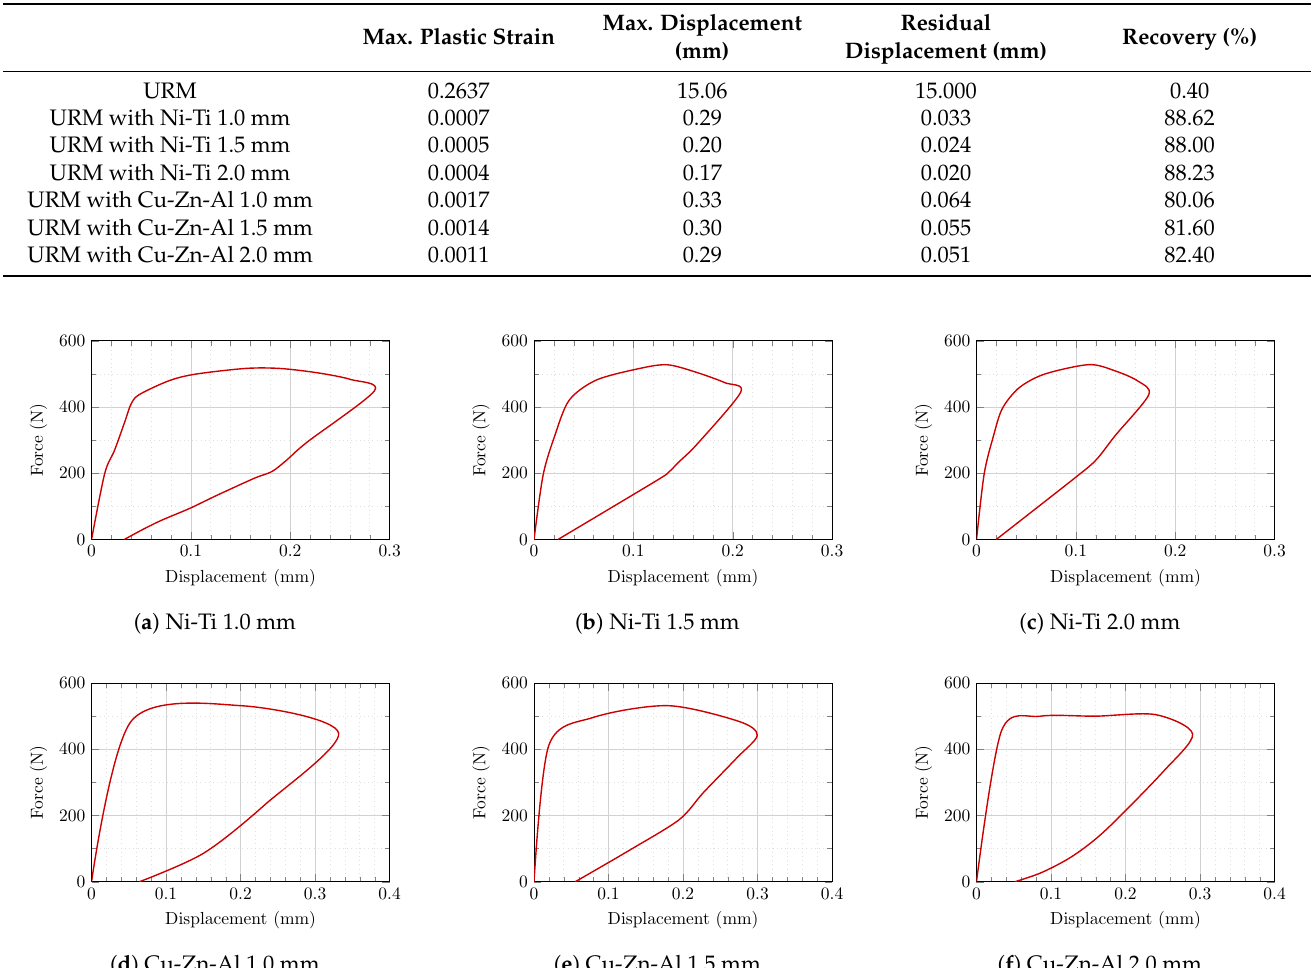
Table 4. Summary of the FEA results.